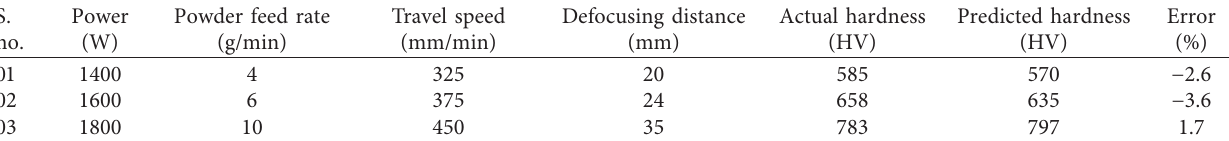
Table 8: Validation test results for the developed empirical relationship.